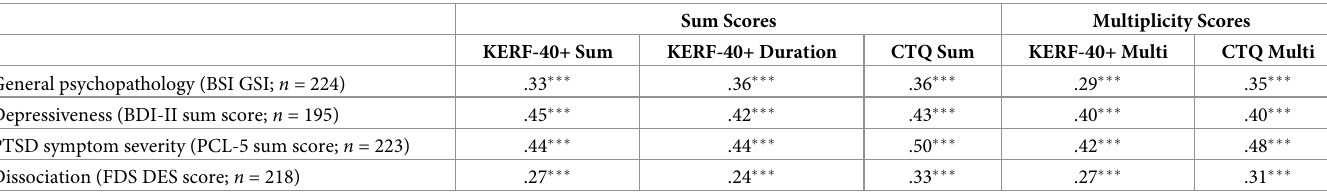
Table 5. Relative predictive validity, as indicated by correlations between KERF-40+ scores, CTQ scores and psychometric measures of